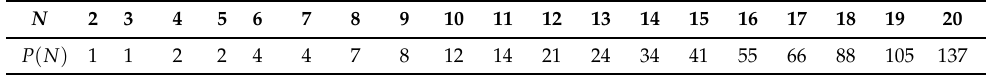
Table 2. The N − dependence of the number P ( N ) of partitions (18) at N ≤ 20.